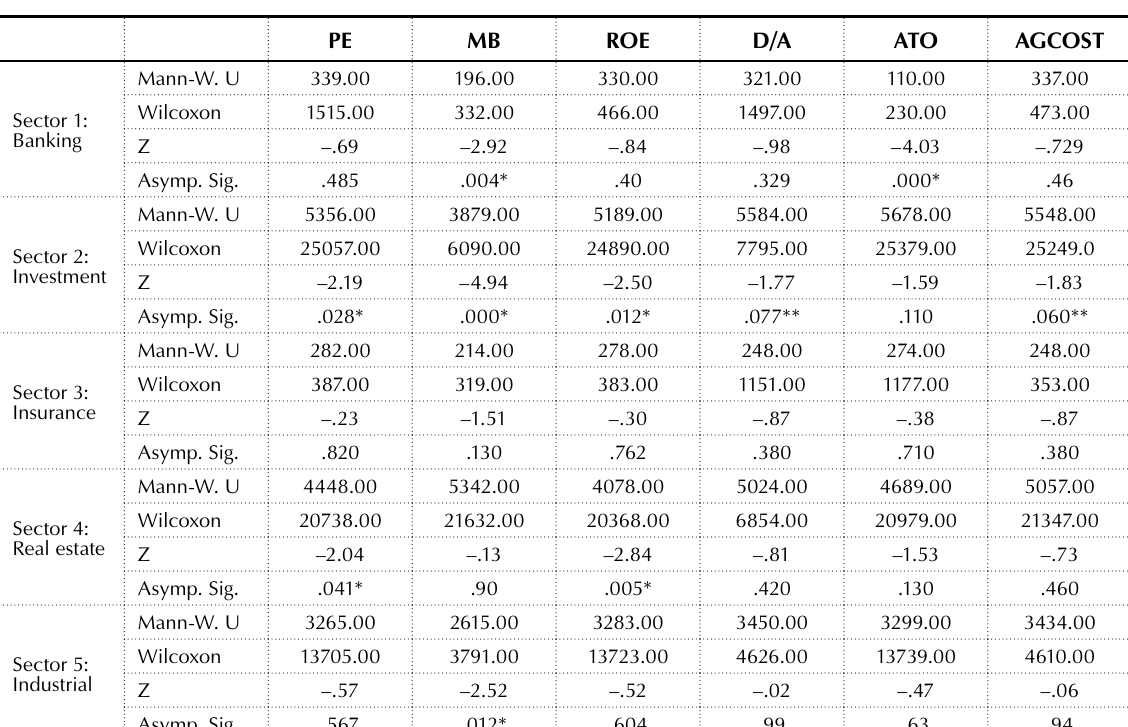
Table 3b. Mann-Whitney U test with KCL